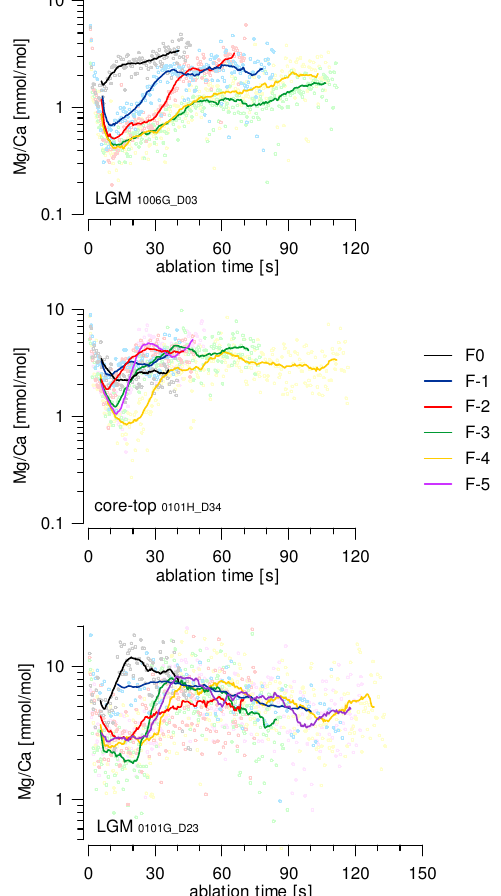
Fig. 6. Mg/Ca profiles through individual N. dutertrei chambers from SE South African margin sediments, both core-top and LGM age. Dots represent raw data, thick lines 25-point smoothed aver- ages that highlight the double-layered structure of the test walls. Note differences in the scale of the y-axes. The difference between the layers is statistically robust at the 95% confidence interval (Stu- dent’s t-test on